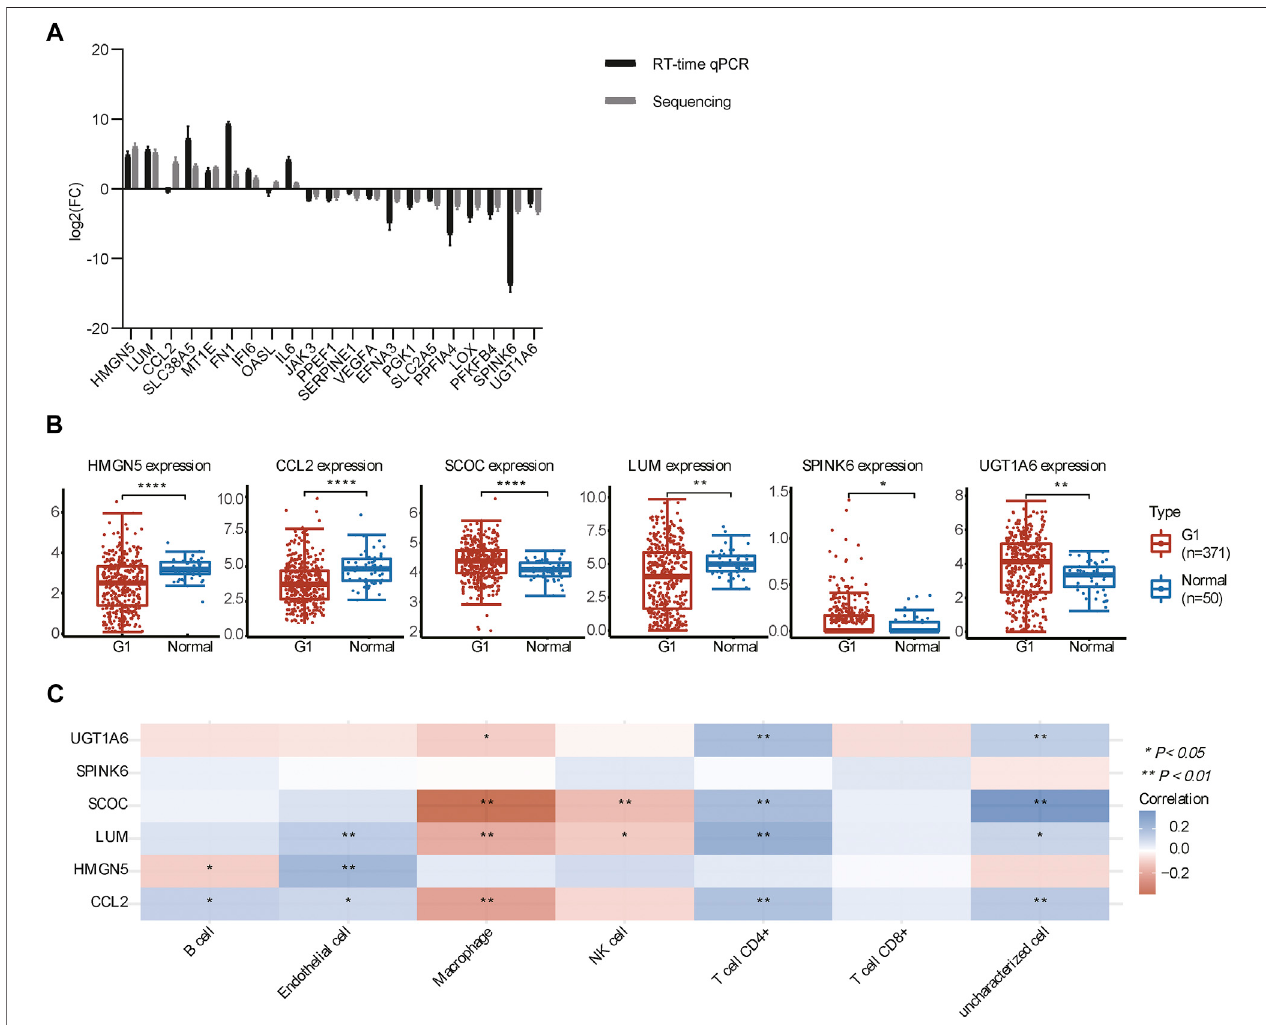
FIGURE6| DEGexpression analysisbyRT-qPCRandinTCGA. (A) ExpressionofDEGsinthe HIF1A -KOand LACZ -controlHepG2cells. (B) ExpressionofDEGs in tumor and normal tissues in TCGA (* p < 0.05, ** p < 0.01, and **** p < 0.0001). (C) Heat map of the correlation between multiple genes and immune cells in HCC. The horizontal and vertical coordinates represent genes, different colors represent correlation coef fi cients (blue represents positive correlation and red represents negative correlation), and the darker color represents the two stronger correlations (* p < 0.05 and ** p < 0.01).